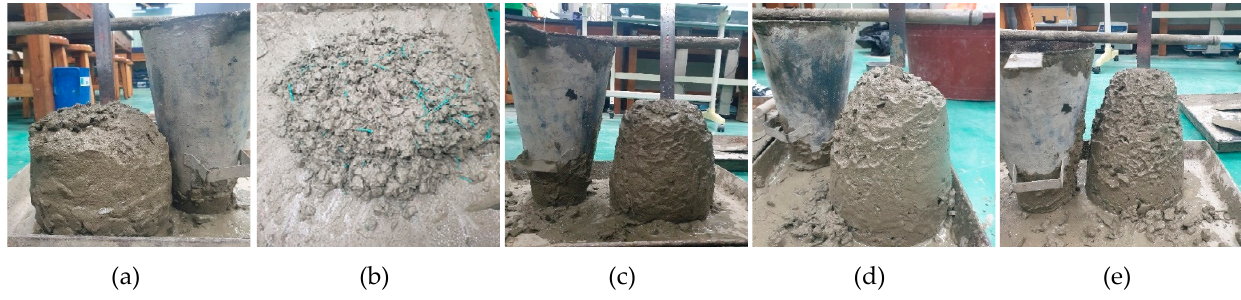
Figure 3. ( a ) Slump test for plain mix; ( b ) fresh wet mix of WFN fiber-reinforced concrete. Slump test for fresh mix of WFN fiber-reinforced concrete: ( c ) 1% WFN fiber-reinforced concrete; ( d ) 2% WFN fiber-reinforced concrete; ( e ) 3% WFN fiber-reinforced concrete. Table 5. Summary of test samples.